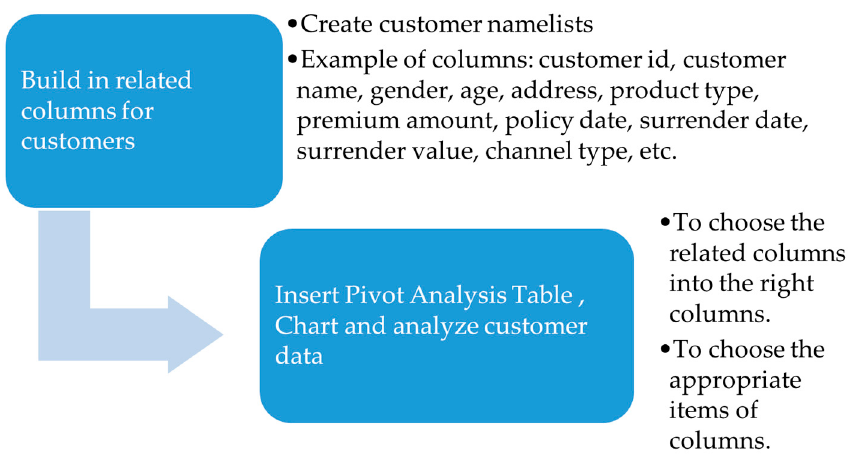
Figure 3. The procedures to simulate the OLAP through inserting pivot analysis tables and charts.